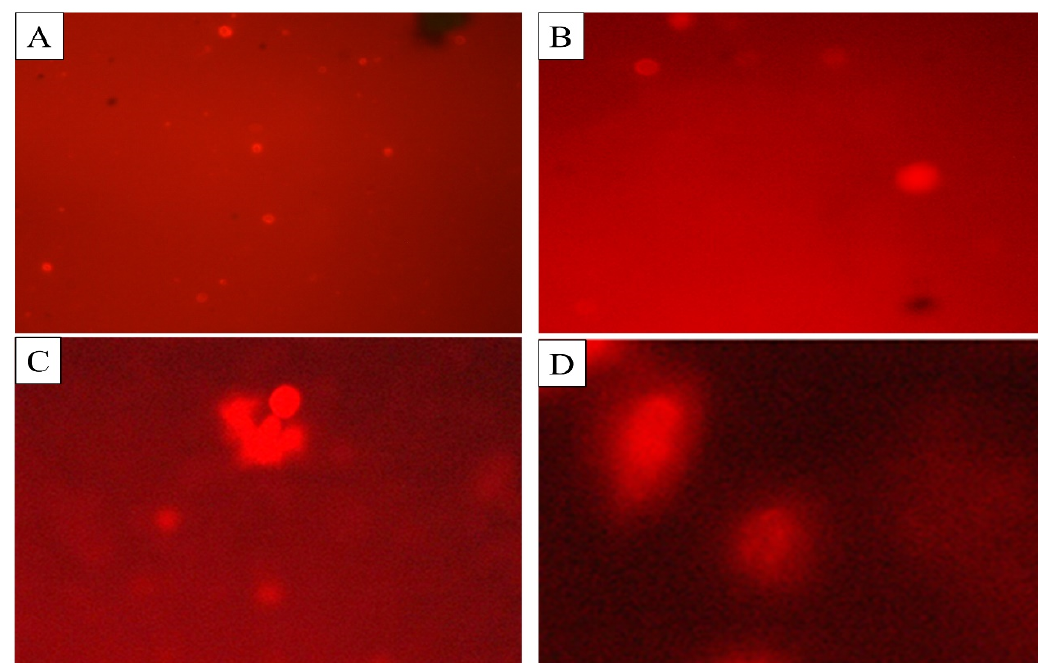
Figure 6. DNA damage of C. quinquefasciatus larvae at different concentrations of BEHP determined through Comet assay. ( A ): Control (without BEHP), ( B ): 100 ppm concentration, ( C ): 150 ppm concentration and ( D ): 250 ppm concentration of BEHP.